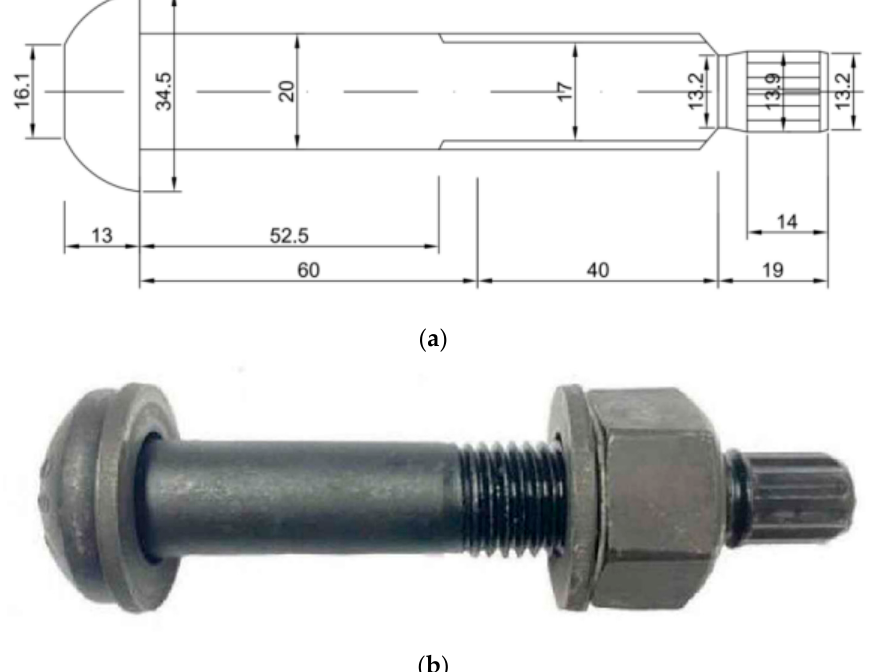
Figure 1. Torque ‐ shear high strength bolts investigated in this study. ( a ) Dimensions. ( b ) A